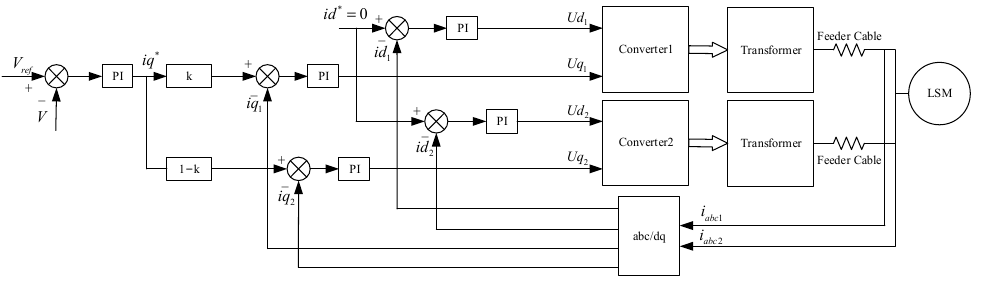
Figure 2. Control strategy of LLSM in this paper.